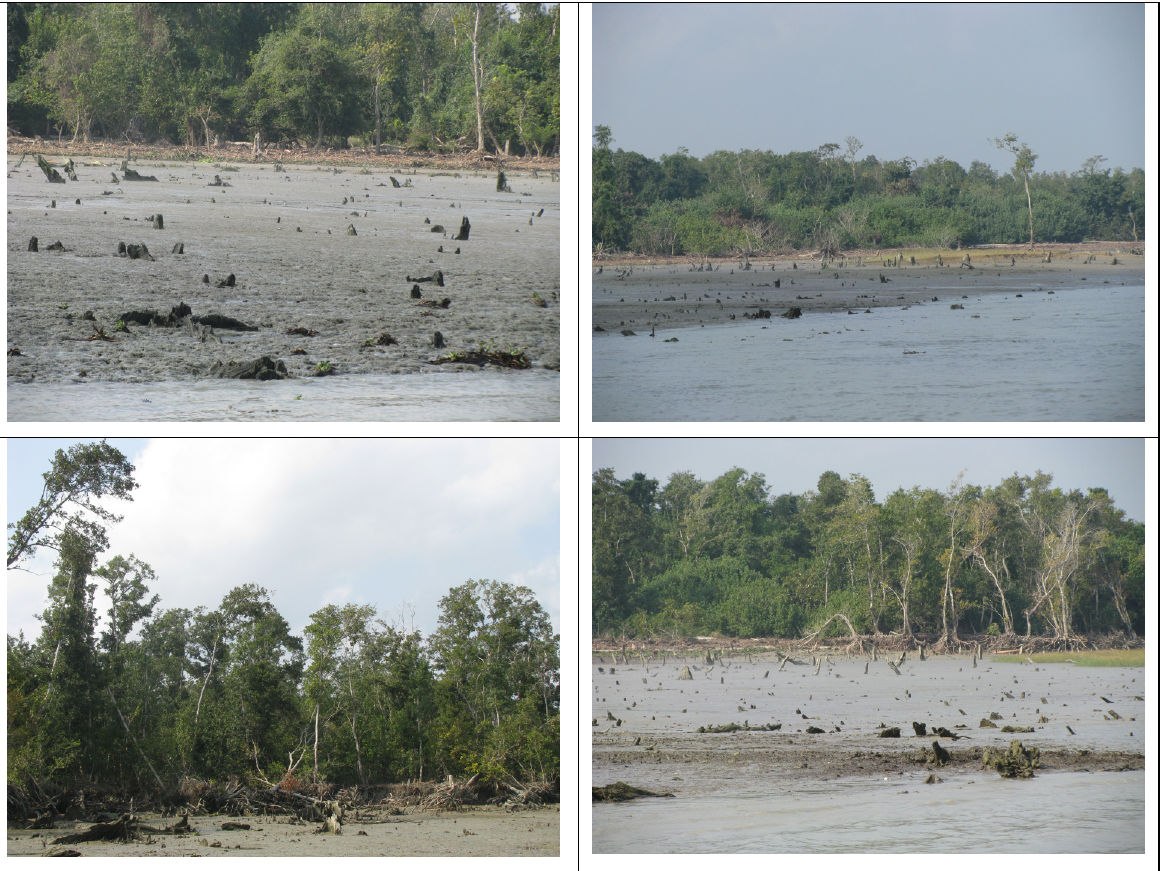
Figure 4. Photographs represent the patterns of coastal erosion in the Sundarbans mangrove